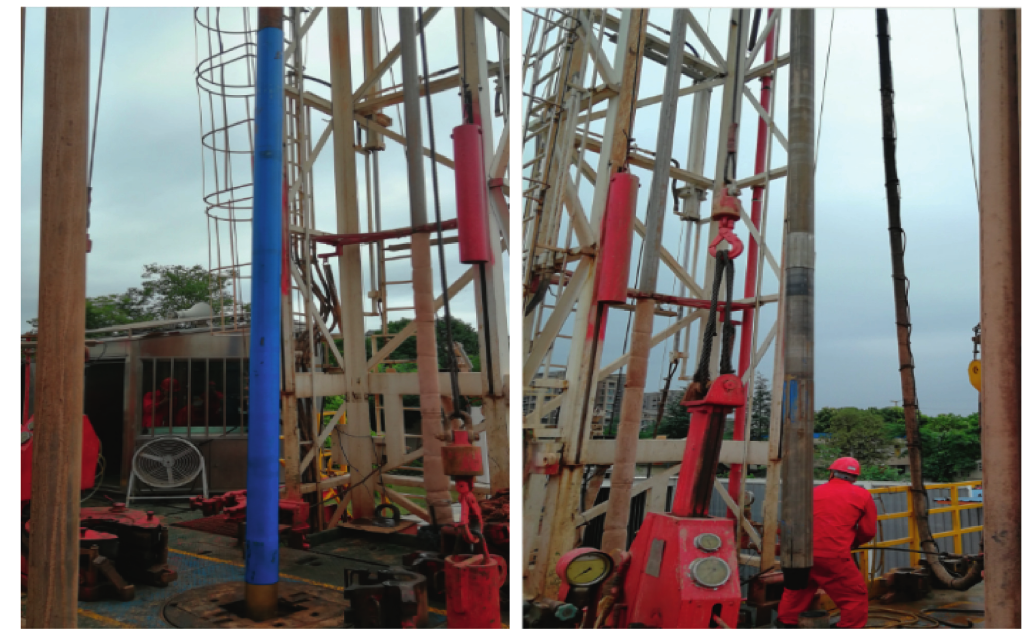
Figure 4: Tool tripping in and tripping out. Table 1: Drag-reduction test